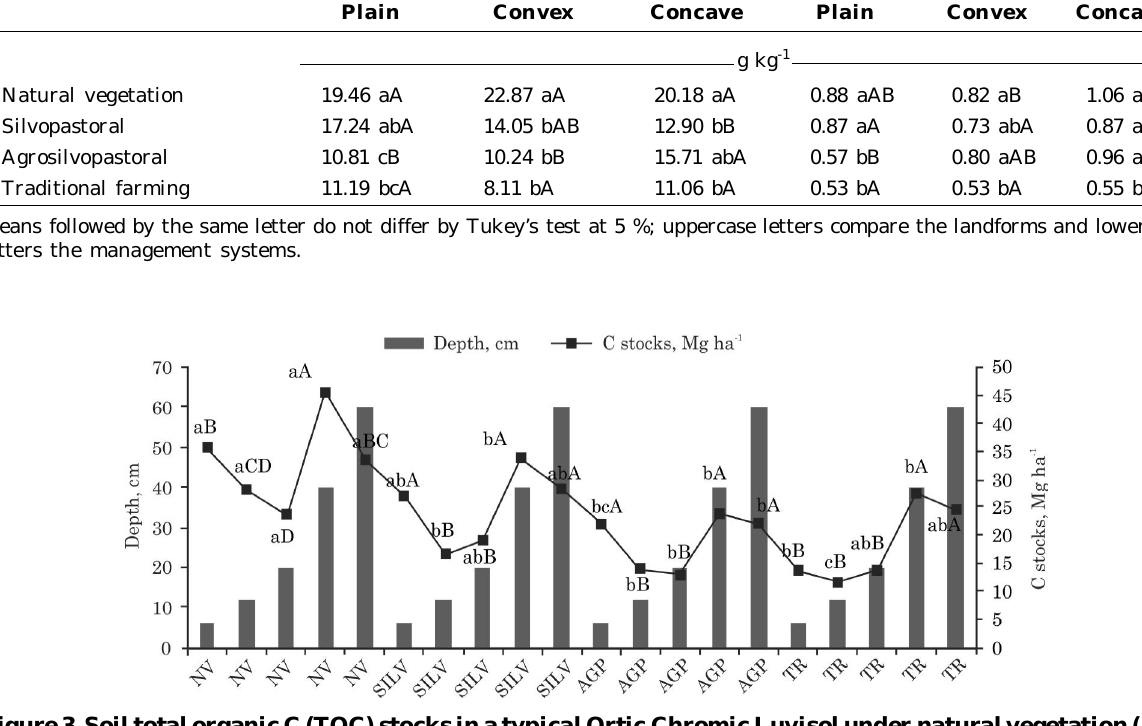
Figure 3. Soil total organic C (TOC) stocks in a typical Ortic Chromic Luvisol under natural vegetation (NV) and silvopastoral (SILV), agrosilvopastoral (AGP) and traditional agricultural (TR) systems after 13 years of cultivation in Sobral, Ceará. Means followed by similar letters do not differ by Tukey’s test at 5 %; uppercase letters compare the layers in each area and lowercase letters the areas in each layer.